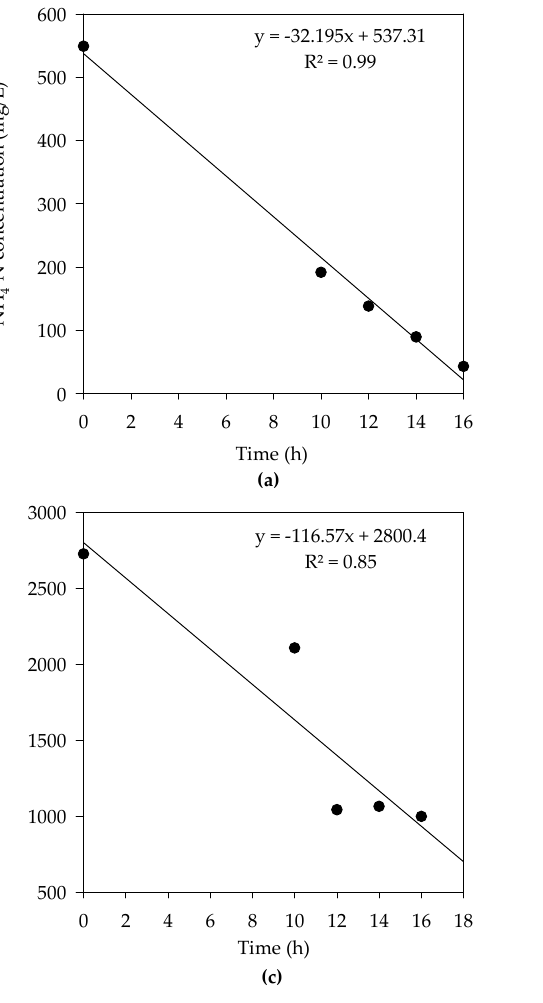
Figure 9. Pseudo zero-order and pseudo first-order kinetics of the electrochemical treatment for ( a ) NH 4 -N, ( b ) TN, ( c ) sTOC, and ( d ) color. The obtained reaction rates were 32.2 mg-NH 4 -N / L · h, 0.1126 mg-TN / L.h, 116.6 mg-sTOC / L · h, and 736.2 color units / L · h. The NH 4 -N and TN followed pseudo zero-order kinetics and pseudo first-order kinetics, respectively. The NH 4 -N was fitted well (R 2 = 0.99) on pseudo zero-order kinetics and TN was fitted well (R 2 = 0.98) on pseudo first-order kinetics, while the sTOC and color removal were also fitted well on pseudo zero-order kinetics.